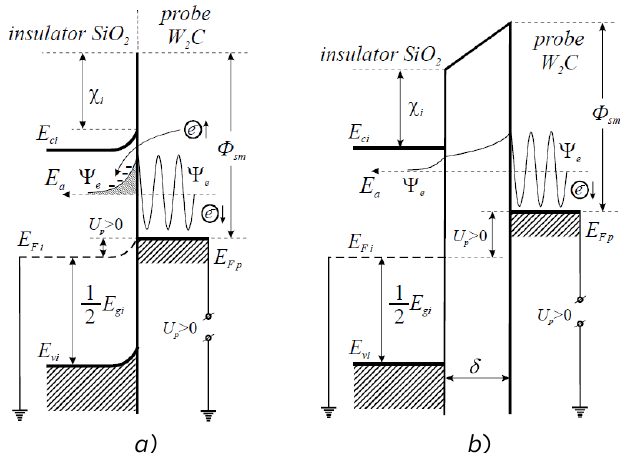
Fig. 3. The energy diagrams of the probe-dielectric system with the grounded sample (structure) and application of positive bias U p >0: a ) to the immediate contact of the probe and dielectric, b ) to the tunnel-transparent gap  10 nm between them.